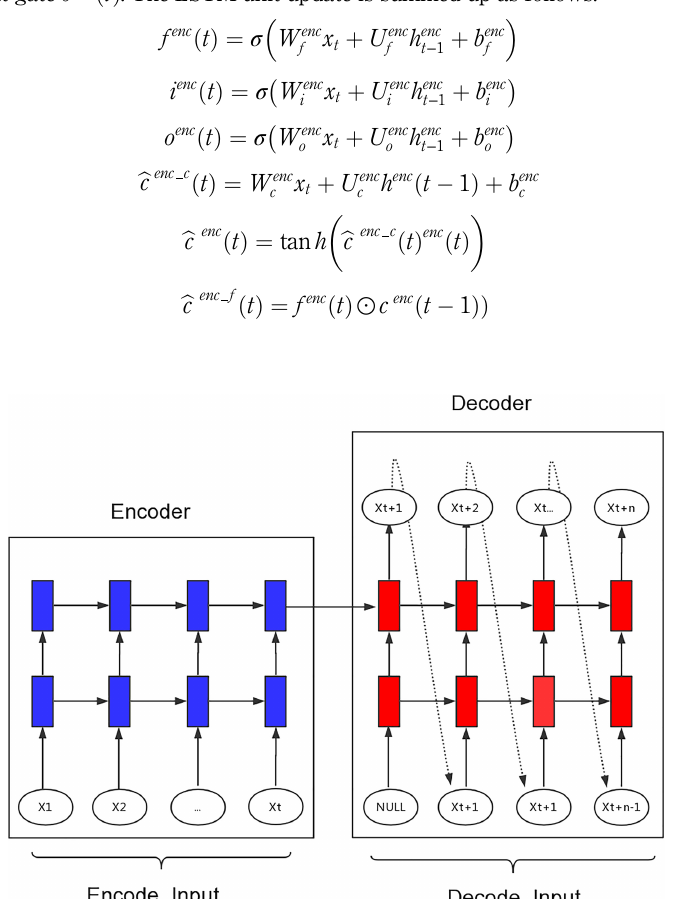
Figure 4. The architecture of the Seq2Seq LSTM architecture, including encoder and decoder